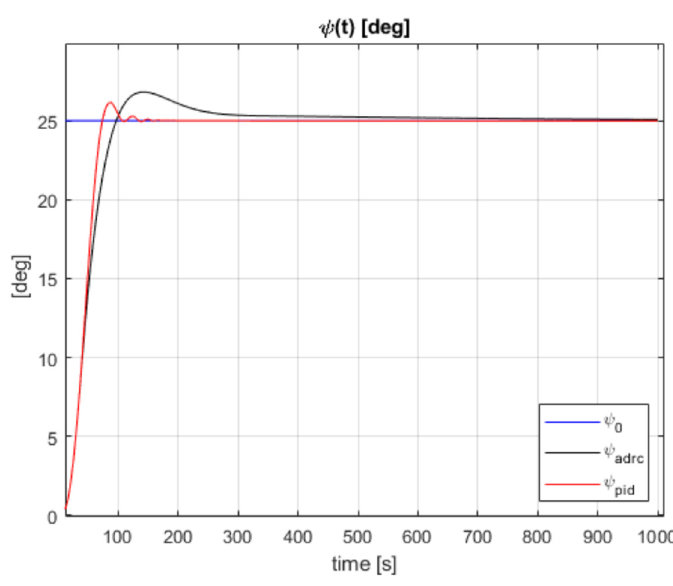
Figure 6. Comparison of ADRC to PID.